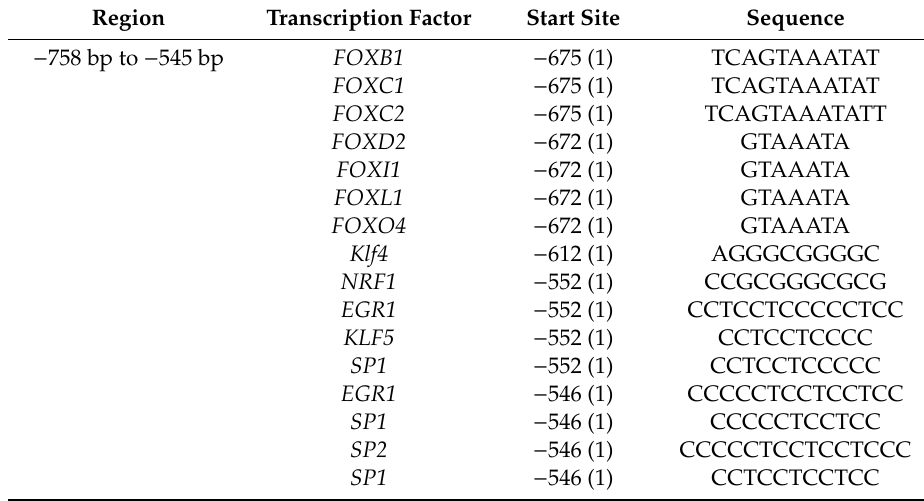
Table 3. Transcription factor binding sites predicted in the region from − 758 bp to − 545 bp of BMP7 promoter.